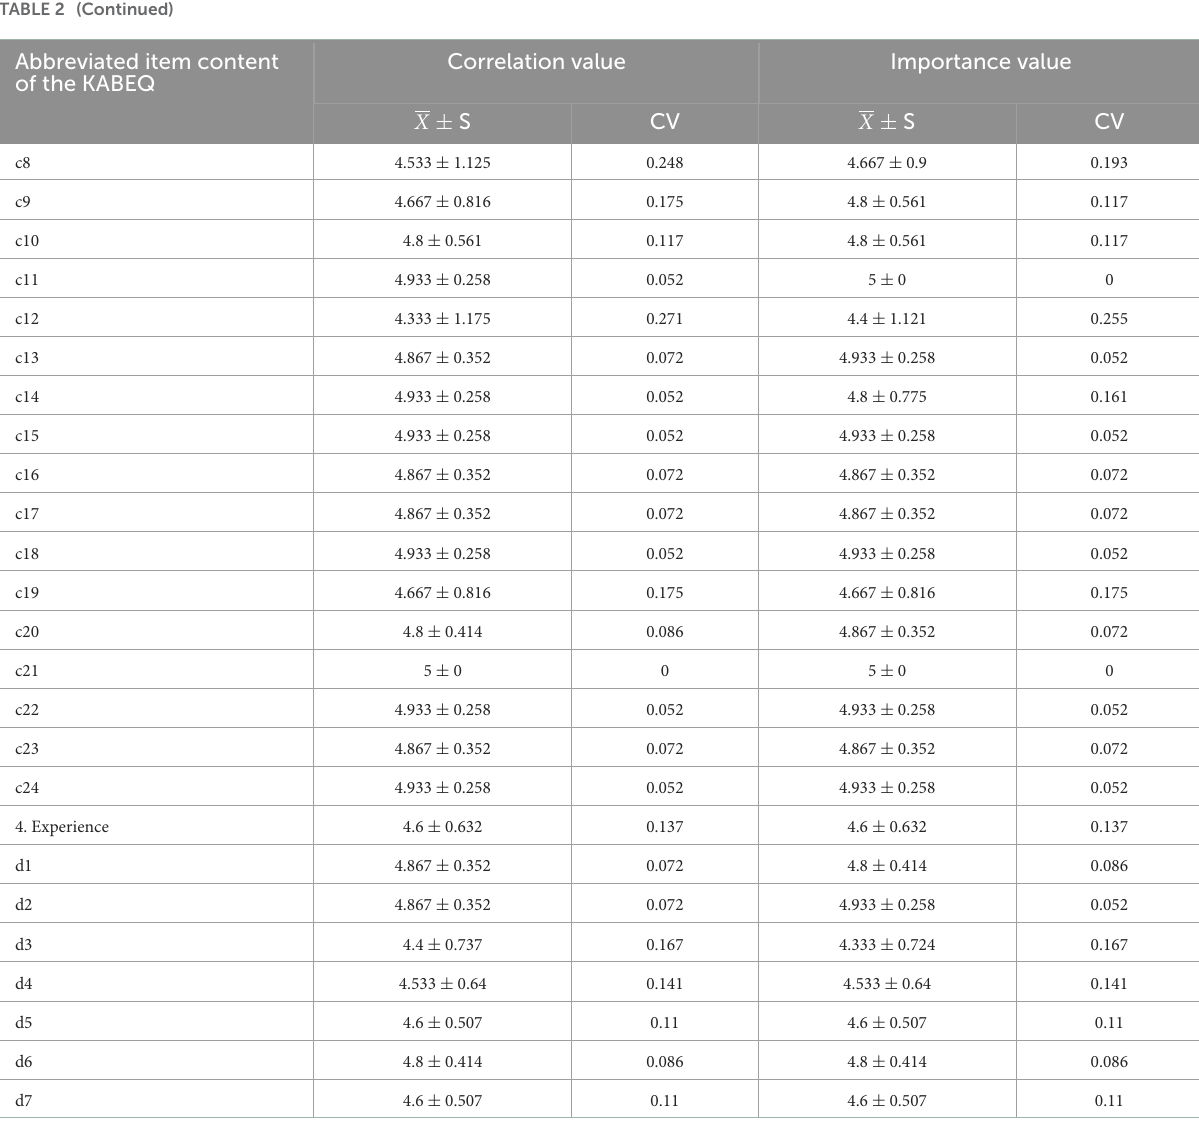
TABLE 3 Coordinate coefficients of expert advice for two rounds of